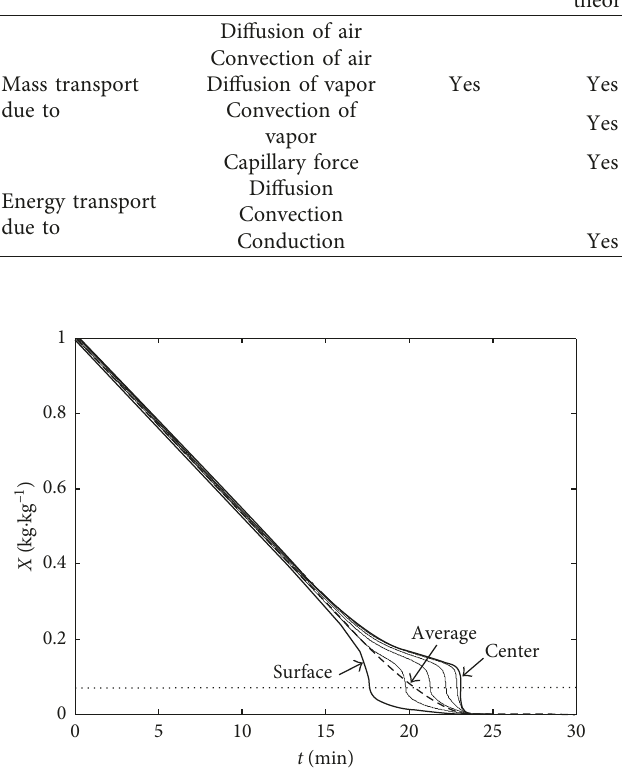
Figure 4: Drying of a sphere of light concrete: temporal evolution of moisture content for approximately every 0.5mm in